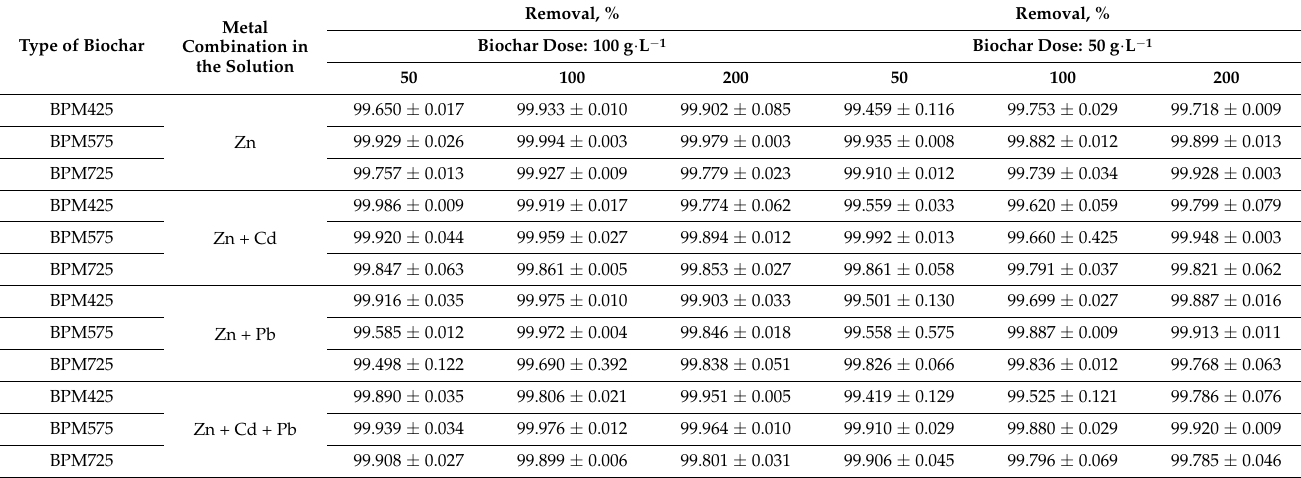
Table 8. Removal of Zn (%) from the solutions with mono-, double- and triple-metal combinations.